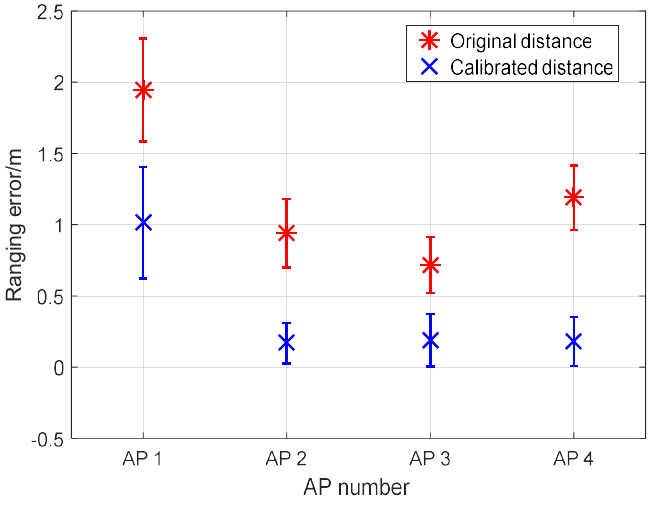
Figure 8. The error bars of ranging errors of four APs on a TP.